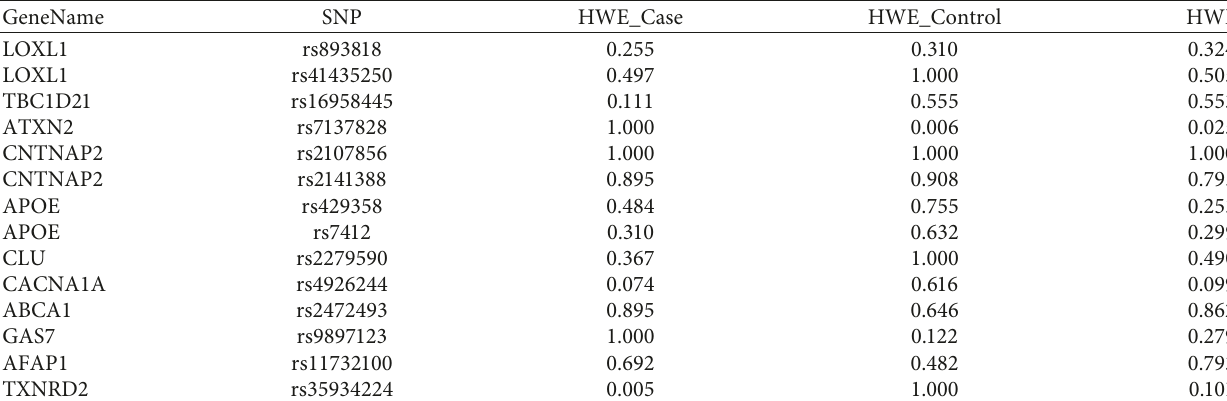
Table 2: Hardy–Weinberg equilibrium test of these SNPs.